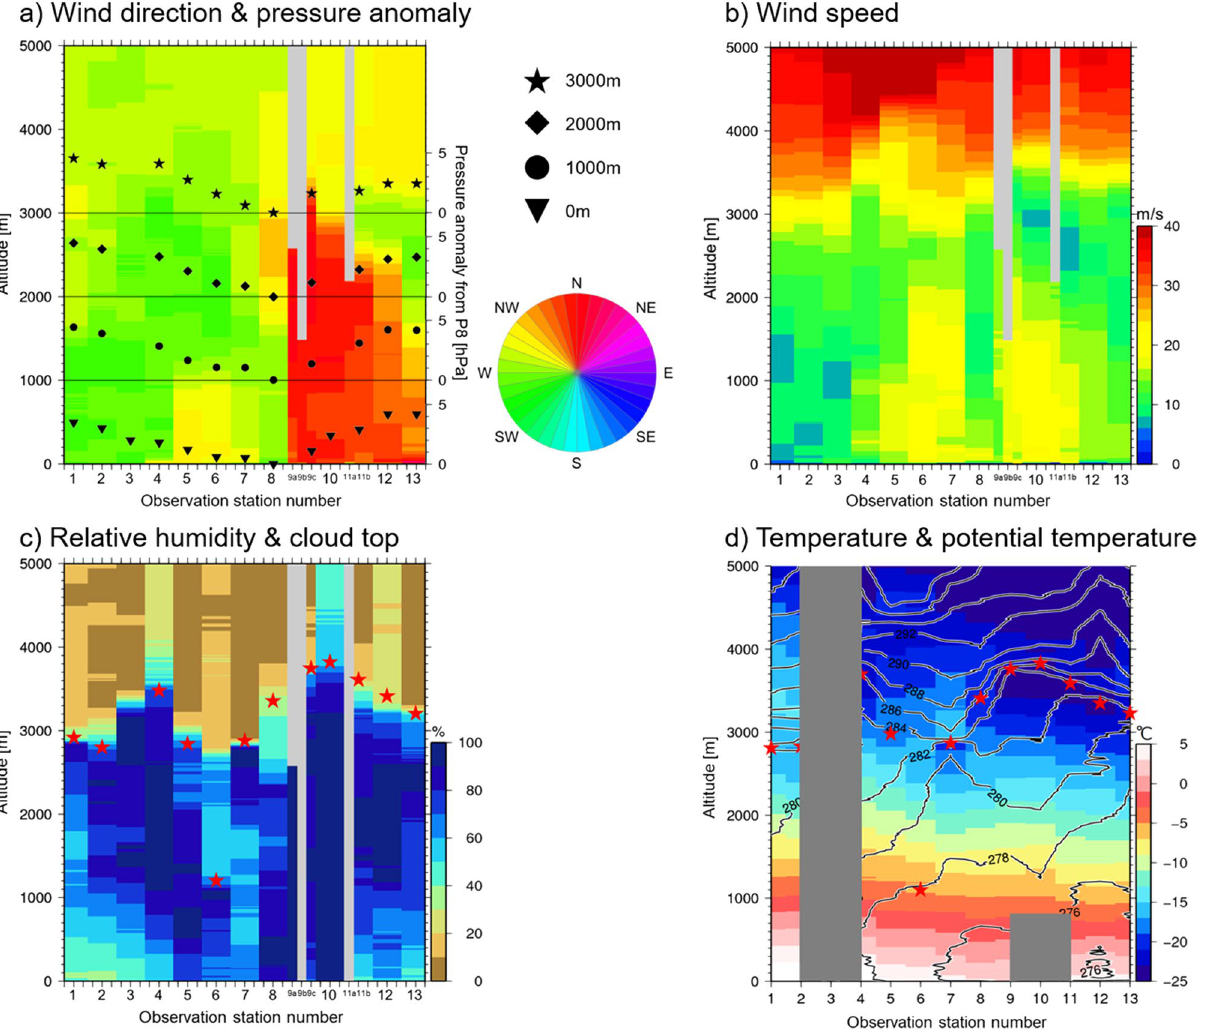
Figure 2. Horizontal airflow convergence reached altitudes of 3.5 km in association with wind direction changes. Atmospheric horizontal-vertical cross sections along the observation stations. ( a ) Colour shows wind direction. Reddish and greenish indicate north and west winds, respectively, as shown in the pie chart. Triangle, circle, square and star symbols are pressure anomalies at 0, 1000, 2000, and 3000 m, respectively. The anomaly is deviation from observation station P8, at which minimum pressure was recorded. The scale of the pressure anomaly is indicated on the right y-axis. Horizontal thin lines are zero lines for the pressure anomalies at each altitude. ( b ) The same as in ( a ) but for wind speed. ( c ) The same as in ( a ) but for relative humidity. Star symbols show cloud top heights. The cloud top altitude was determined from the agreement between the temperature significant level and altitude of the rapid decrease in relative humidity to below 85% 20,21 . ( d ) Colours indicate temperatures, and contours show potential temperature. Star symbols show the heights of temperature inversion layers. Others are same as in ( a ). Gray indicates missing